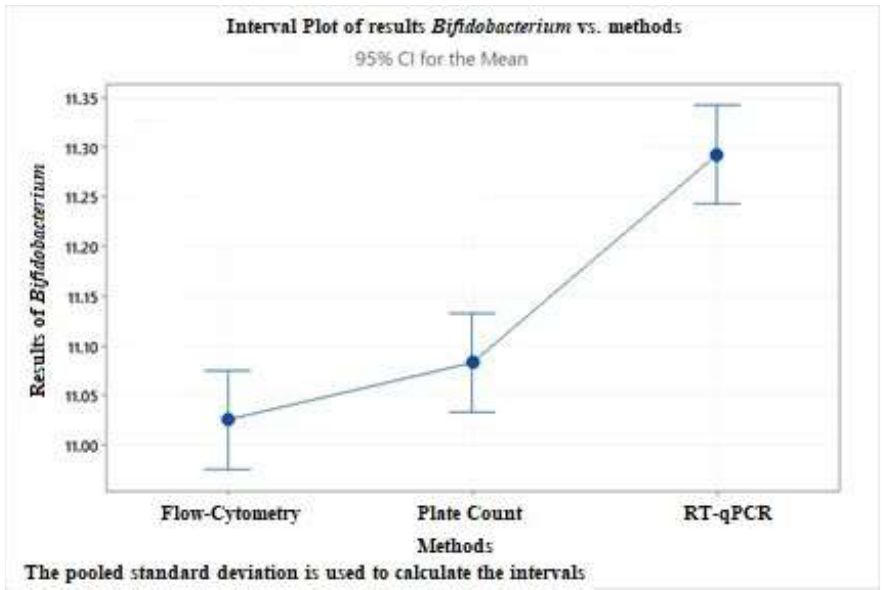
Figure 6. Interval graph representing the difference in counting between Bifidobacterium spp. count in food supplement 2 obtained from the three methods tested. CI: confidence interval.